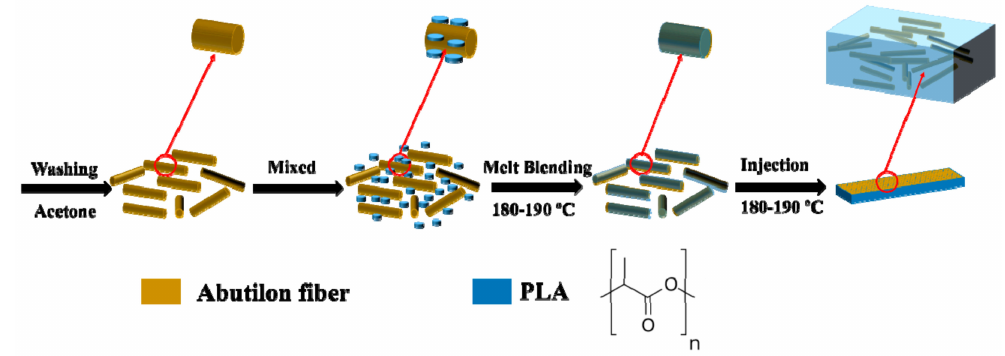
Figure 1. Scheme of fiber and composite